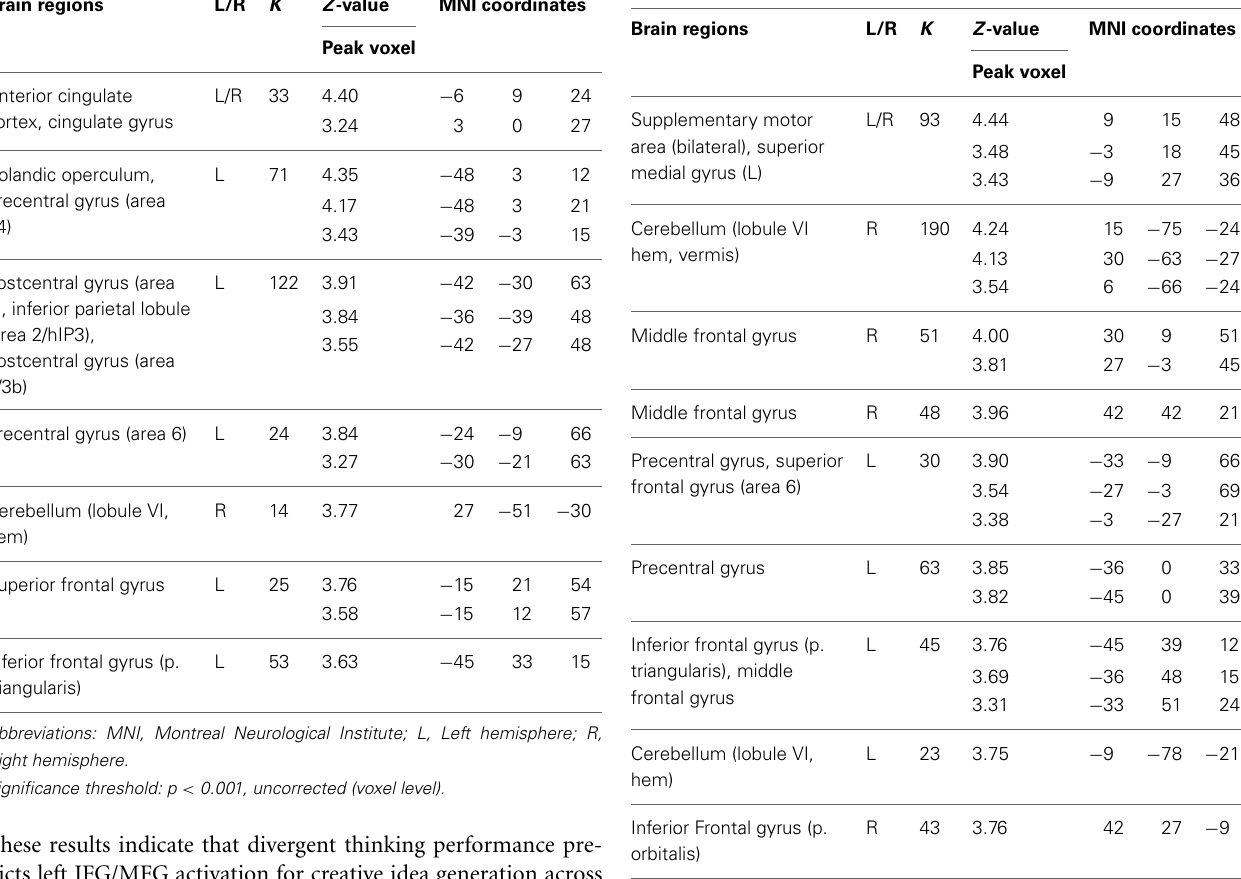
Table 7 | Neural activations for the regression AU > OC with